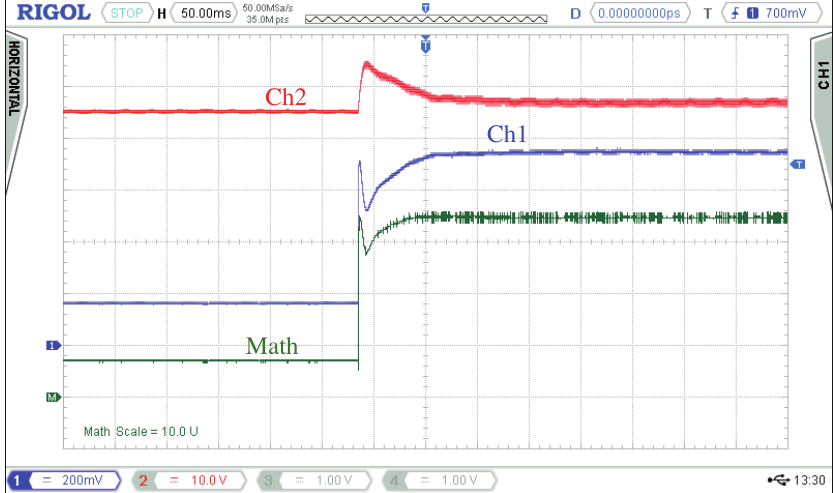
Figure 15. Transient response against an irradiance step from PV4 to PV1. Ch1: PV current (2 A/div). Ch2: PV voltage (10 V/div). Math: PV power (100 W/div).